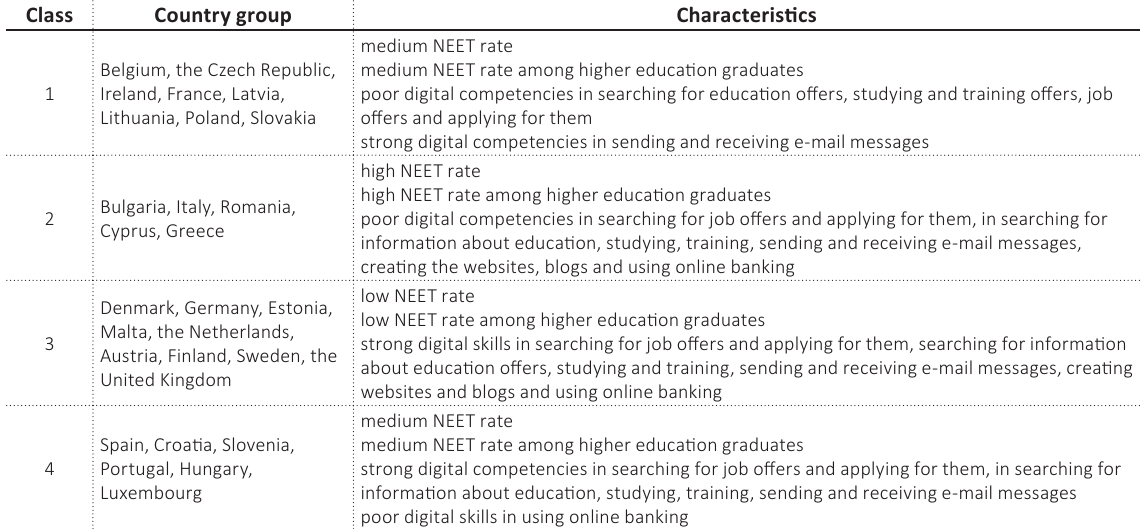
Table 3. The characteristics of the selection of the European Union countries – the results of the cluster